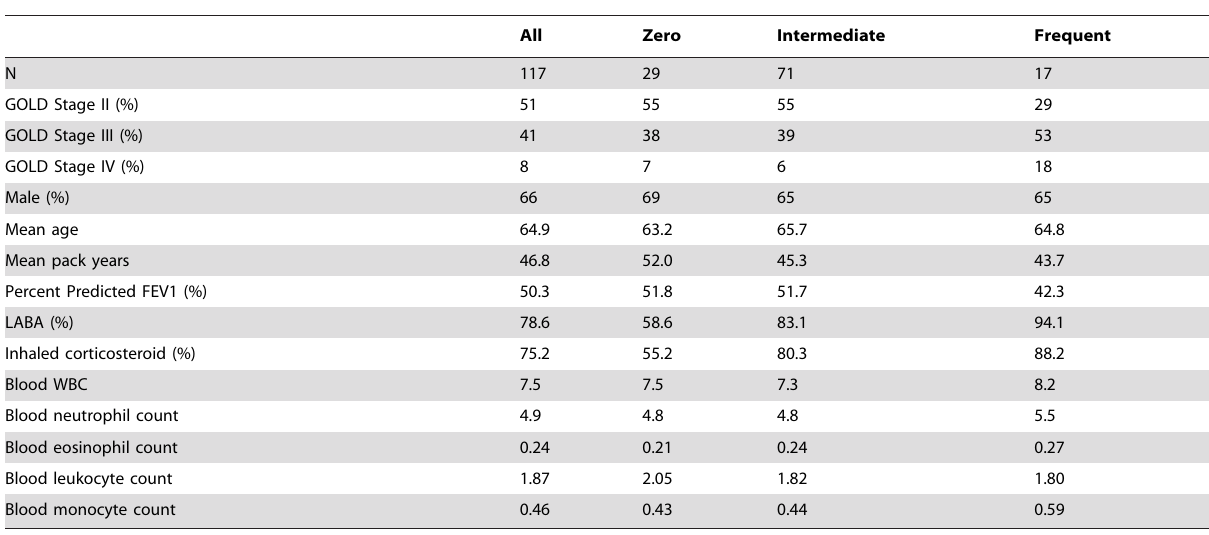
Table 1. Demographics of the COPD subjects for microarray analysis.